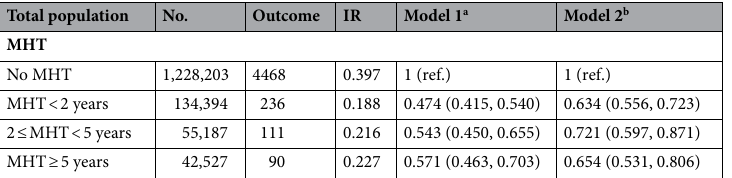
Table 3. Hazard ratios and 95% confidence intervals of ESRD development by history of MHT. ESRD end stage renal disease, MHT menopausal hormone therapy. a Model 1: Not adjusted. b Model 2: Cox proportional model adjusted for age, BMI, smoking history, drinking history, degree of exercise, hypertension, dyslipidemia, diabetes, and